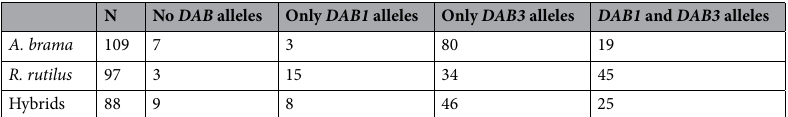
Table 1. Number of specimens for A. brama , R. rutilus and F1 hybrids with the expression of DAB alleles, N is population